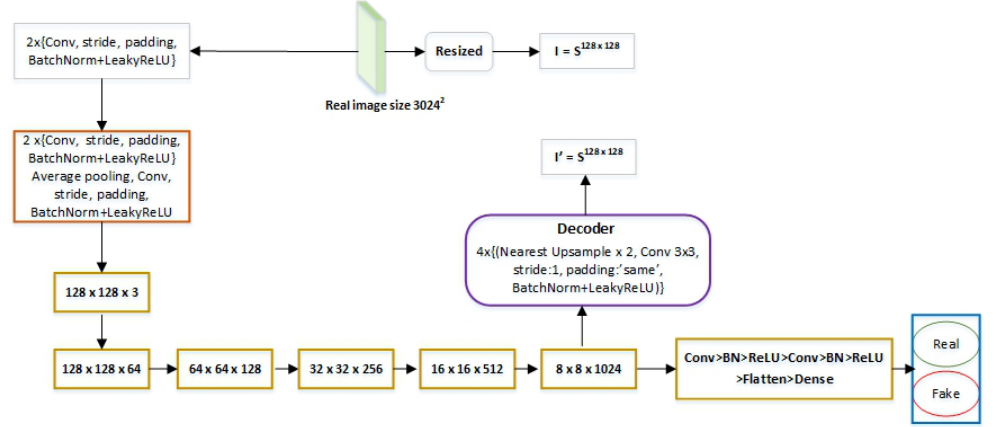
Figure 4. The architecture of the